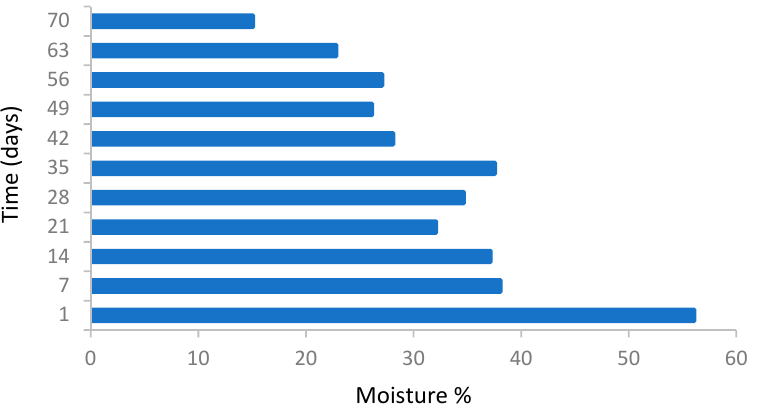
Figure 4. Moisture variations during the composting Figure 4 . Moisture variations during the composting process .